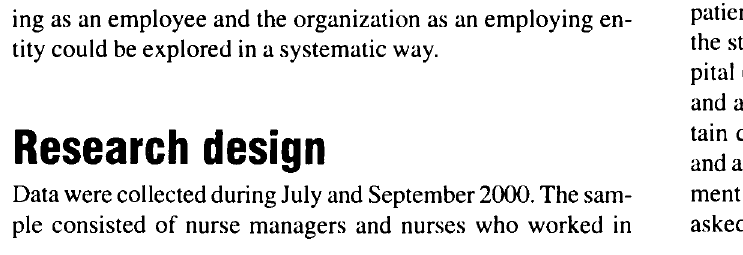
The ten carative factors for a